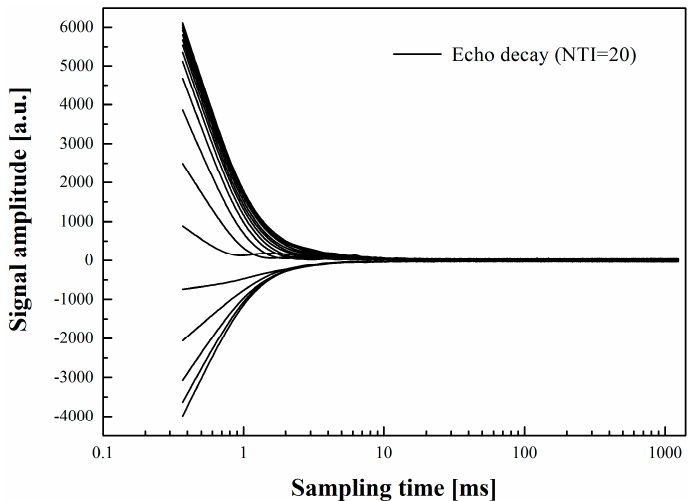
Figure 1. A representative decay of the proton magnetization curves (the sample of CPCA2-SAPs at 7 days) as measured by nuclear magnetic resonance at 0.5 T.